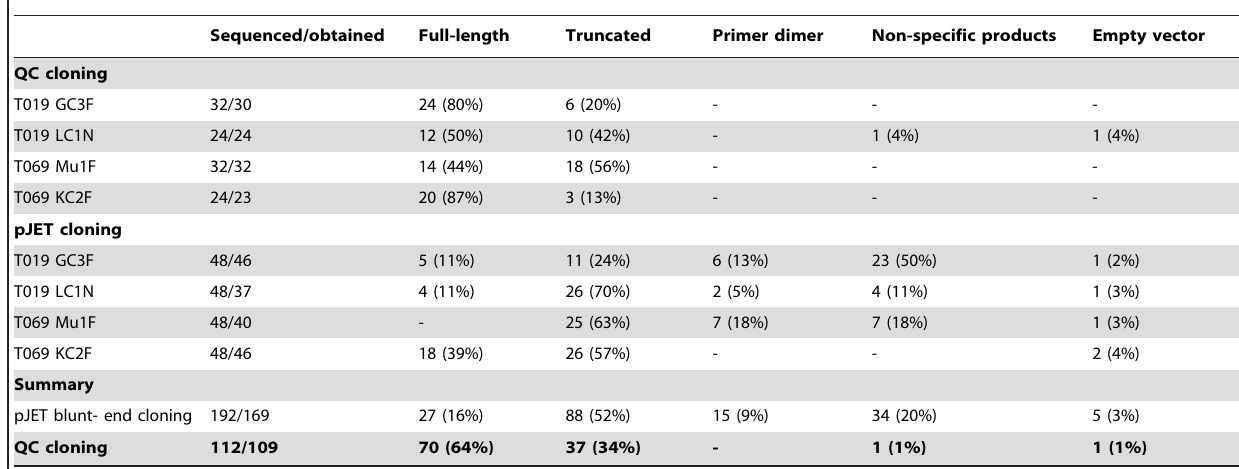
Table 1. Summary of sequencing data obtained for immunoglobulin fragments cloned by QC cloning or pJET blunt-end